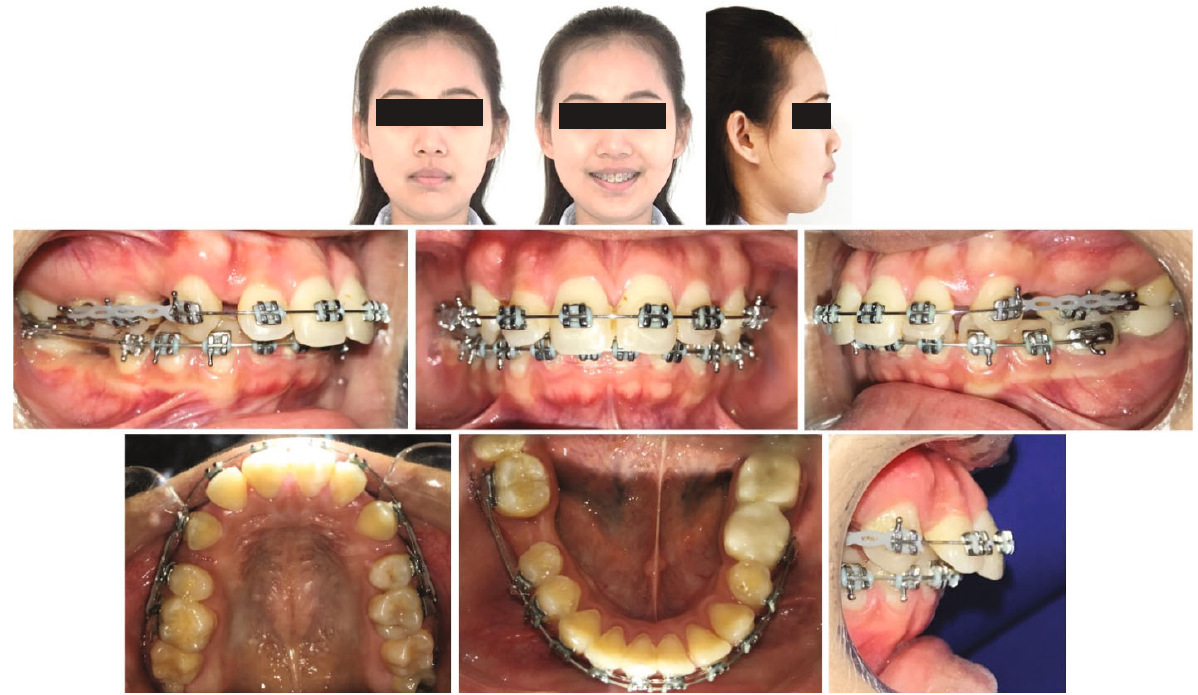
Figure 1: Pretreatment records with prior braces. 0.22 ″ MBT prescription brackets seen with canines half retracted on a 0.016 ″ NiTi